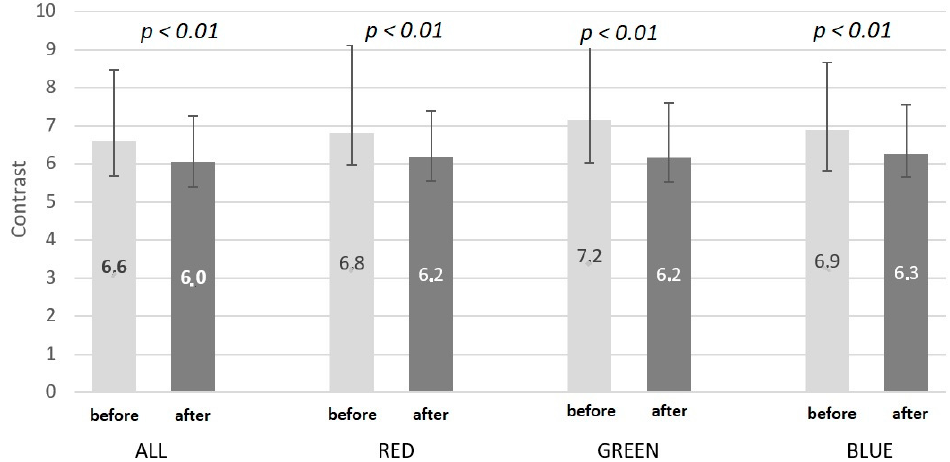
Figure 4. Average GLCM contrast of the treatment spot images in the full color range (ALL) and in red, green and blue channels after conversion to gray levels, in cross polarized light; before—before the first treatment; after—after third treatment.